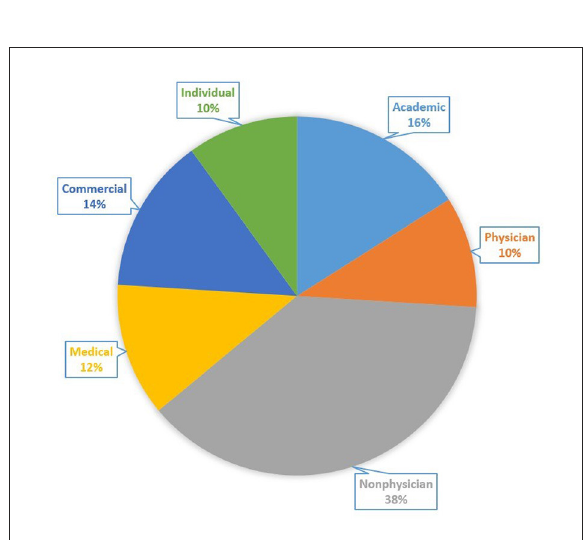
FIGURE2 Categorical distribution of the videos based on source.